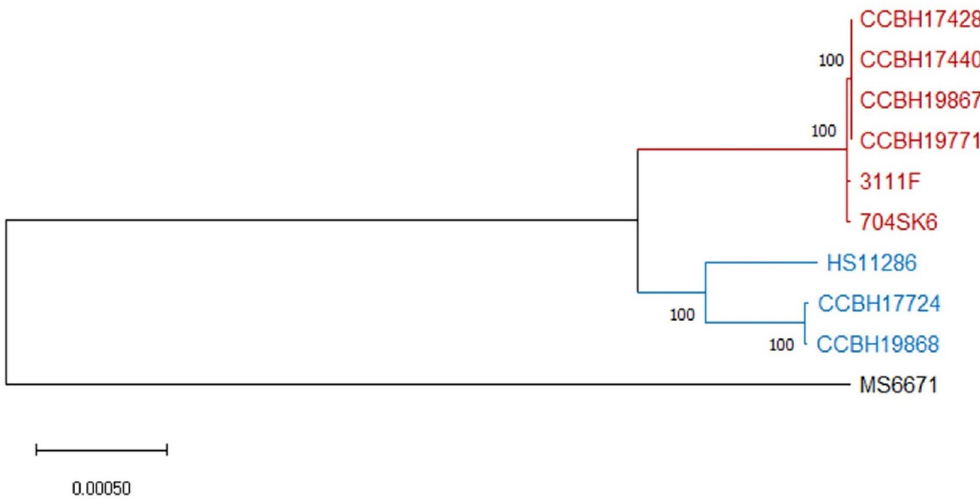
Figure 5. Phylogenetic inference. Neighbor-joining (NJ) distance tree representing phylogenetic relationships between polymyxin-carbapenem-resistant K. pneumoniae of the two distinct MLSTs, ST437 (red) and ST11 (blue), and publicly available genomic sequences 3111F, 704SK6, HS11286 and MS6671 (GenBank assembly accession numbers GCA_002251715.1, GCA_002211665.1, GCA_00240185.2 and GCA_001455995.1, respectively). MS6671 was selected as an outgroup. Numbers displayed in internal branches correspond to bootstrap values. The scale represents the NJ distance.